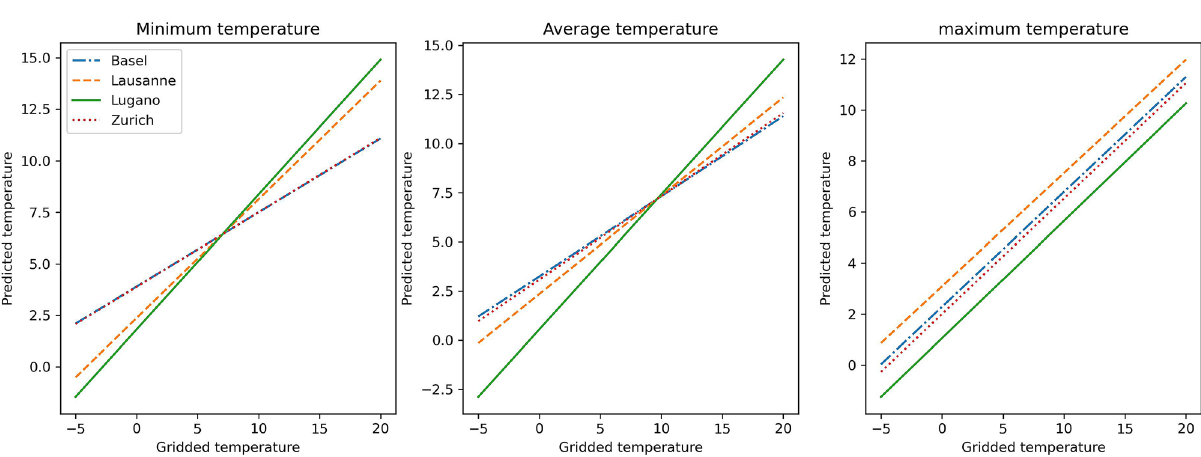
Figure 4. Regression lines obtained from the mixed effects model accounting for the city slope and intercept random